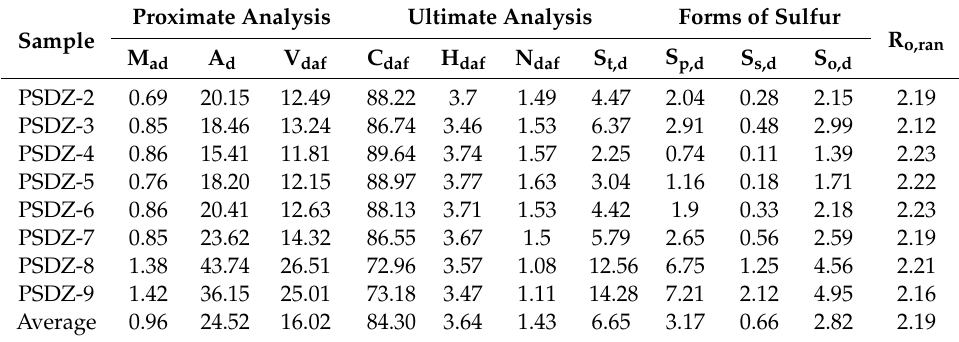
Table 1. Proximate and ultimate analysis, forms of sulfur, and vitrinite random reflectance for the Donggou coals